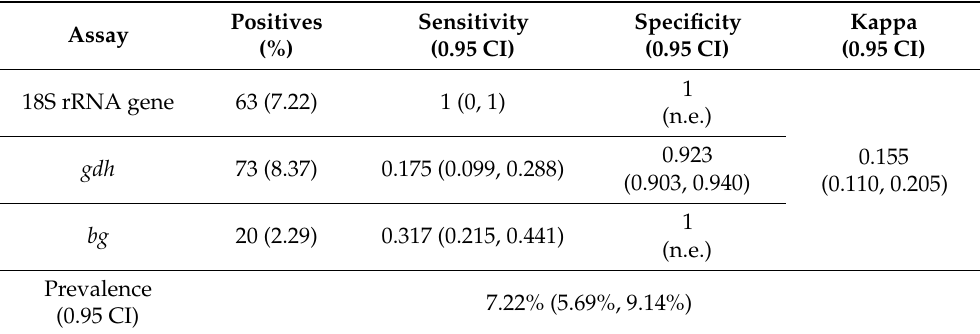
Table 1. Agreement kappa between the compared real-time screening PCR assays targeting G.